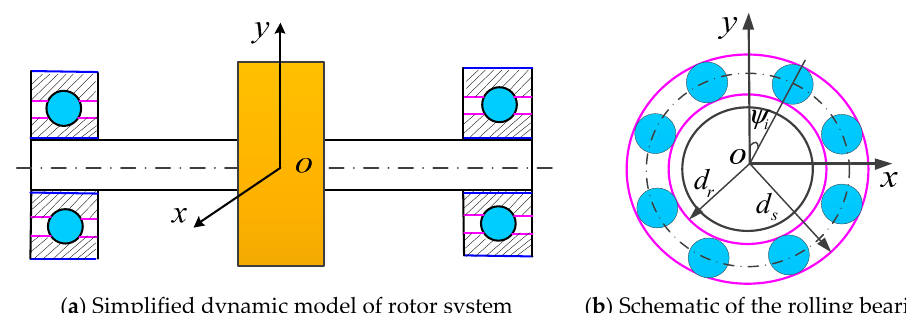
Figure 1. Rotor-bearing dynamic model